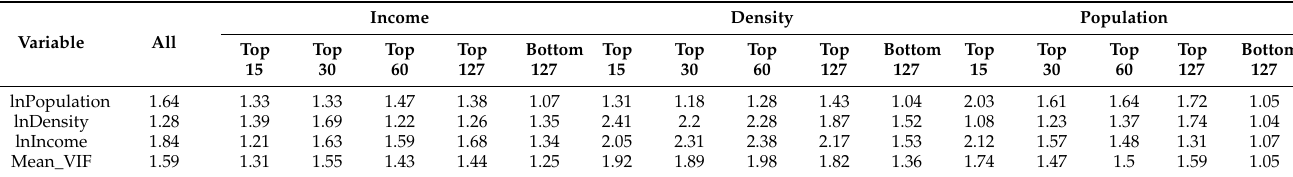
Table 3. VIF test for PM 2.5 data.